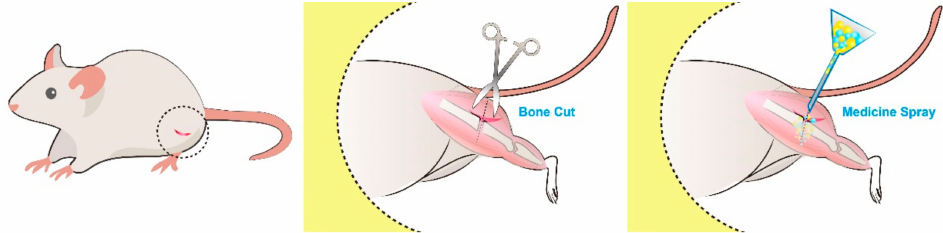
Figure 8. Femur shaft fracture surgical procedure. The lateral part of the middle-thigh region was disinfected, and a 2 cm skin incision was made (left panel). The femur shaft was exposed by blunt dissection of the surrounding musculature. The osteotomy was performed in a short oblique direction with a bone cut (middle panel). The analgesics-incorporated microparticles were directly sprayed on the fracture site (right